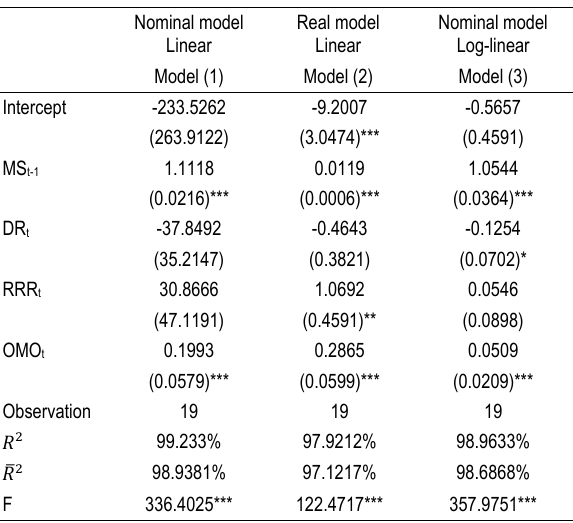
Table 1. The effect of indirect monetary policy tools on money supply. Money supply is the